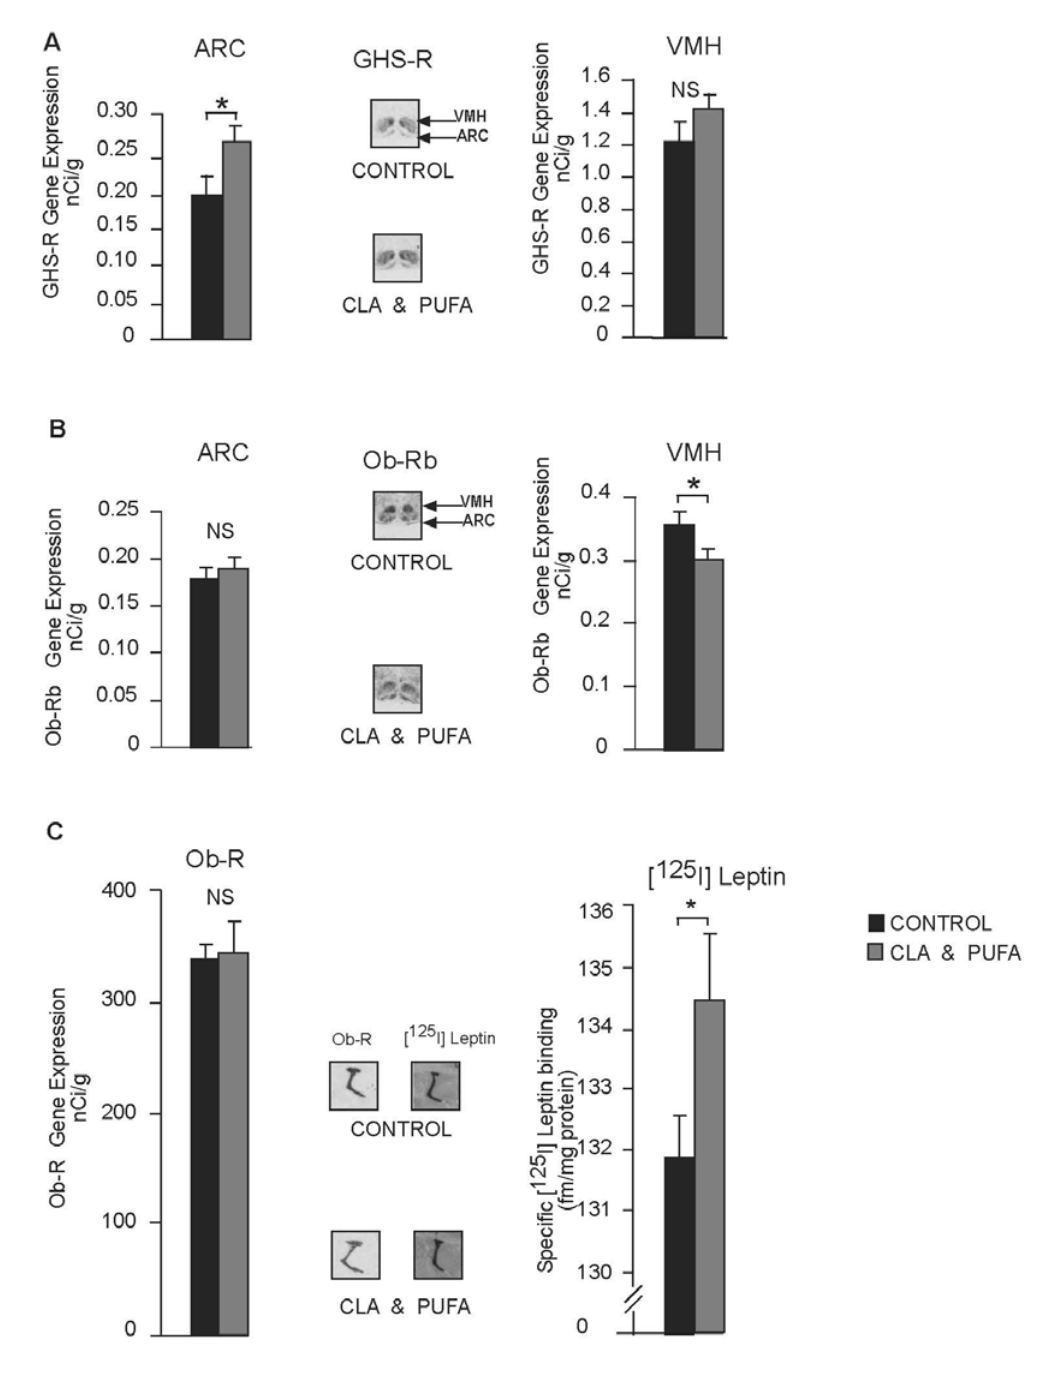
Figure 7. Effect of CLA plus n- 3 LC-PUFA supplementation on hypothalamic receptor gene expression and [ 125 I]leptin binding. A. GHS-R was increased in the arcuate nuclei (ARC), * P < 0.05 but not significantly (NS) changed in the ventromedial nuclei (VMH). B. Ob-Rb was not significantly (NS) changed in the ARC but significantly decreased in the VMH, * P < 0.05. C. There was no significant change (NS) in Ob-R expression in the choroid plexus (CP). The level of specific [ 125 I]leptin binding to the CP was increased significantly after CLA plus n-3 LC-PUFA supplementation in both the CP of the lateral ventricles (not shown) and the dorsal third ventricle, * P <